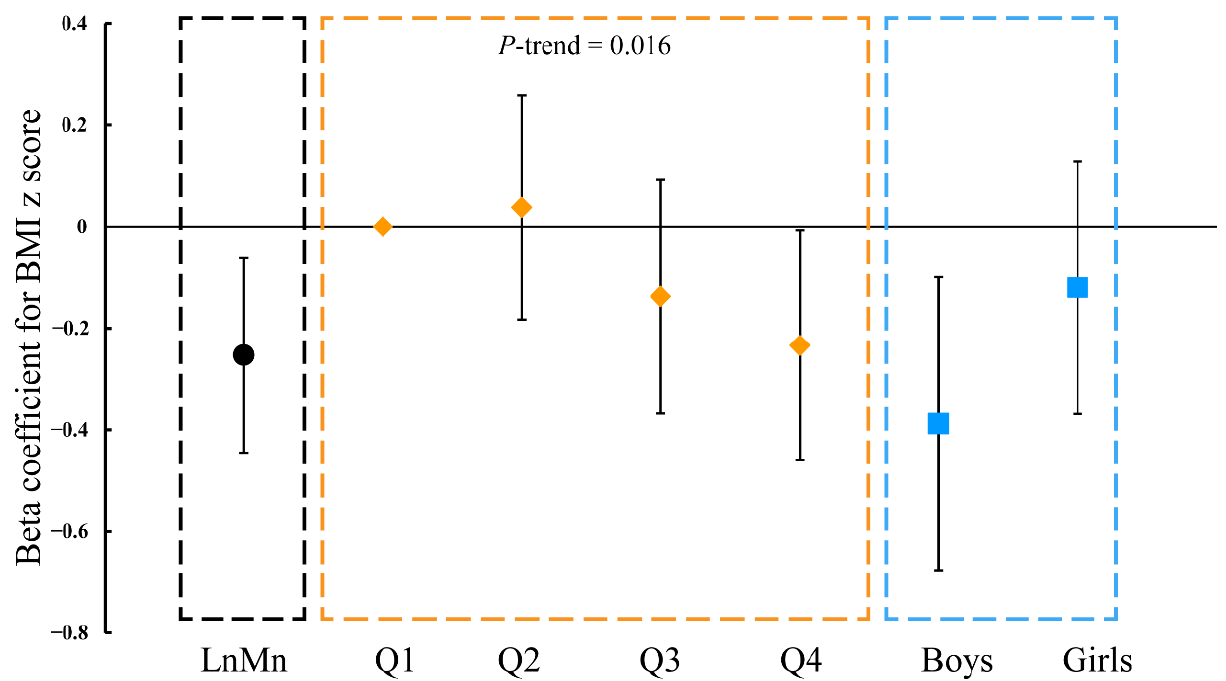
Figure 3. Generalized estimating equation models for associations of body mass. index z score with prenatal Mn exposure. (Abbreviation: BMI—body mass index).